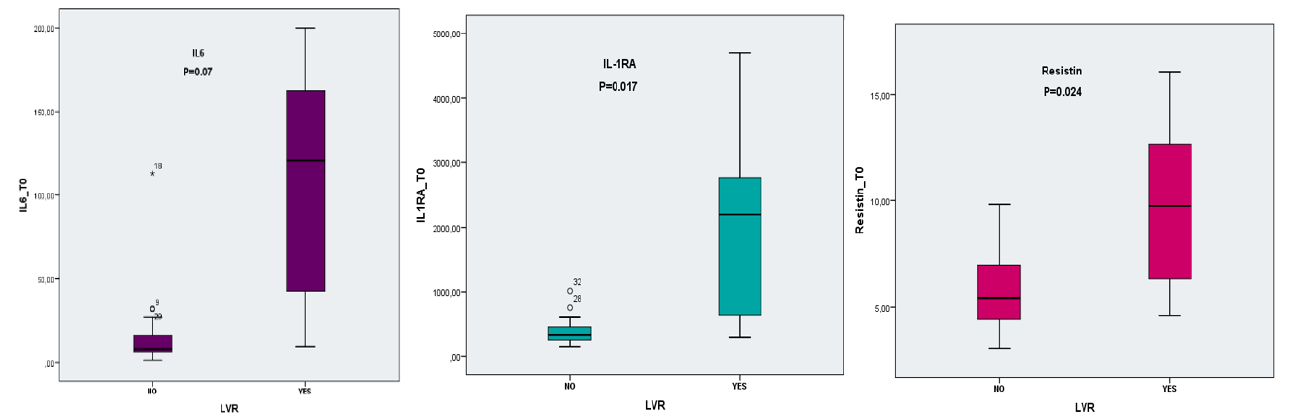
Figure 2. Cytokine levels were significantly higher in the remodelling group.